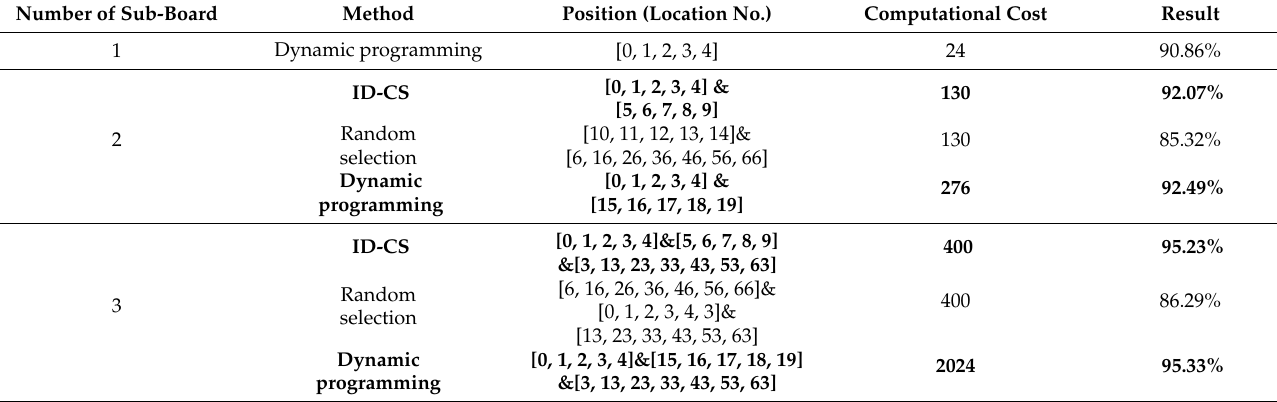
Table 3. Result of different sensor board numbers and position selections from virtual distance sensors. Number of